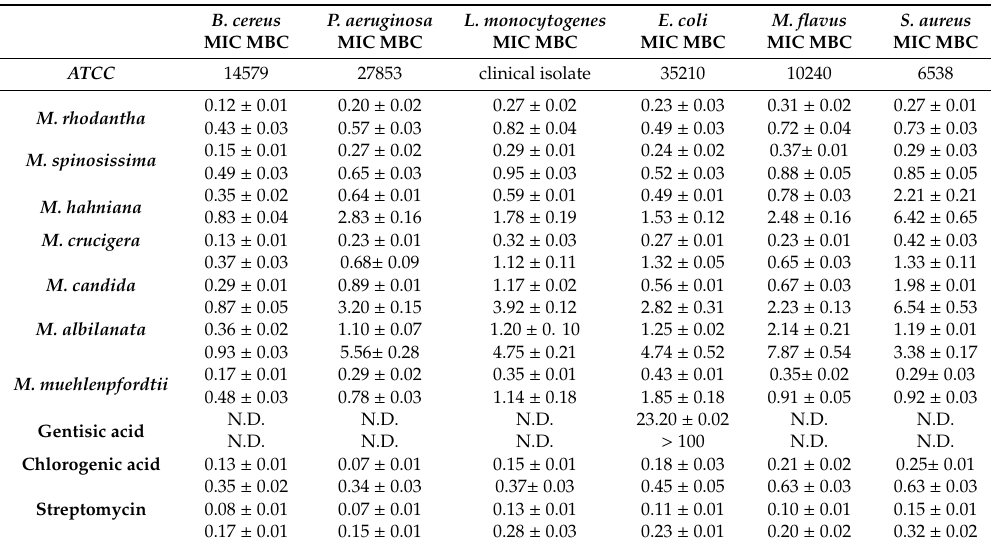
Table 4. Minimum inhibitory (MIC) and bactericidal concentration (MBC) of Mammillaria sp. stem extracts (mg mL − 1 ) as well as gentisic and chlorogenic